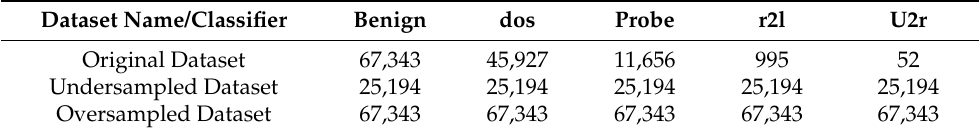
Table 2. Records of each category included in the three variations of the dataset